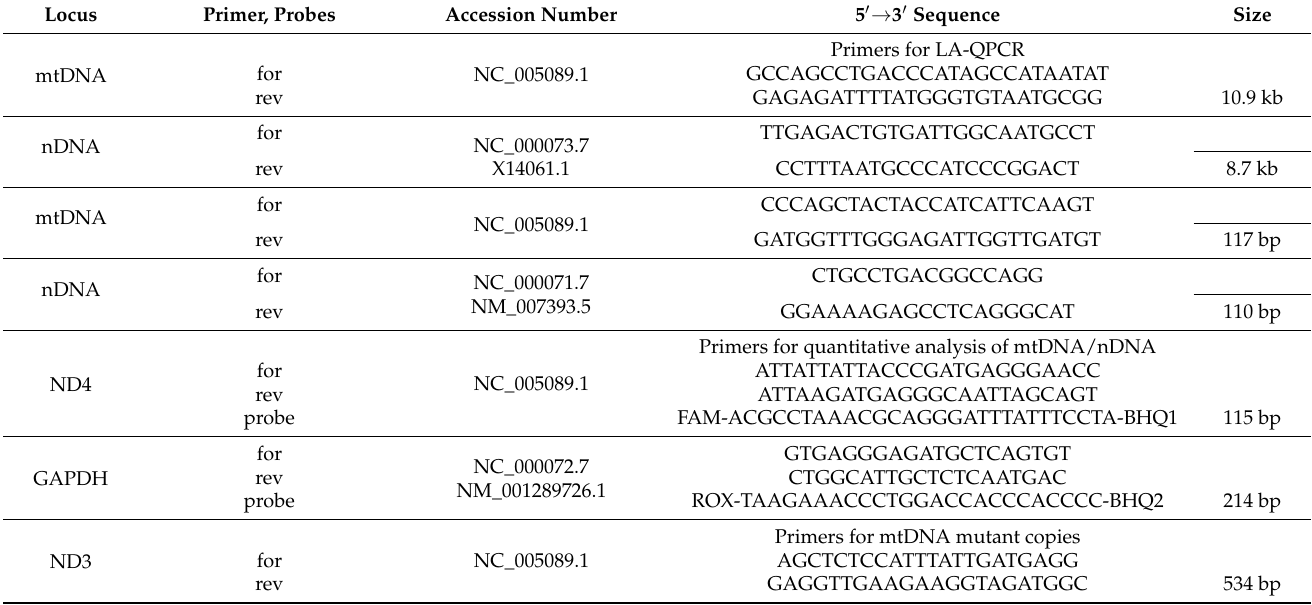
Table 1. Primers and probes used in the current